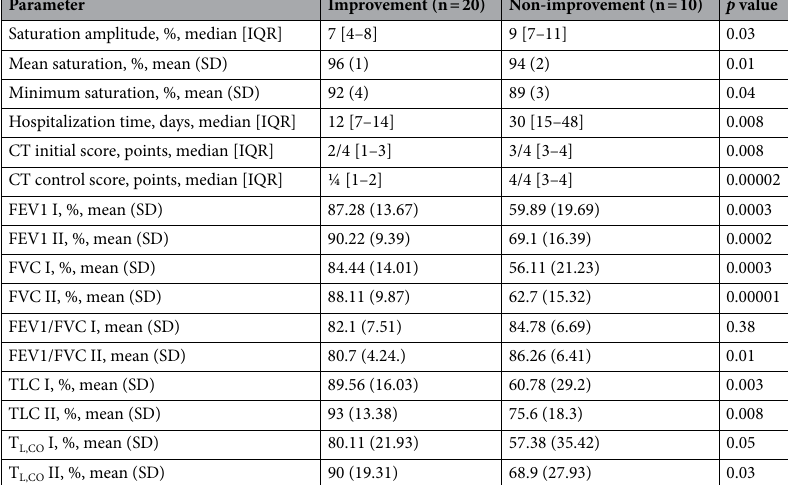
Table 2. Comparison of the improvement and non-improvement participant groups. Pulmonary function tests are presented during the first (I) and second (II) assessments. CT computed tomography, FEV1